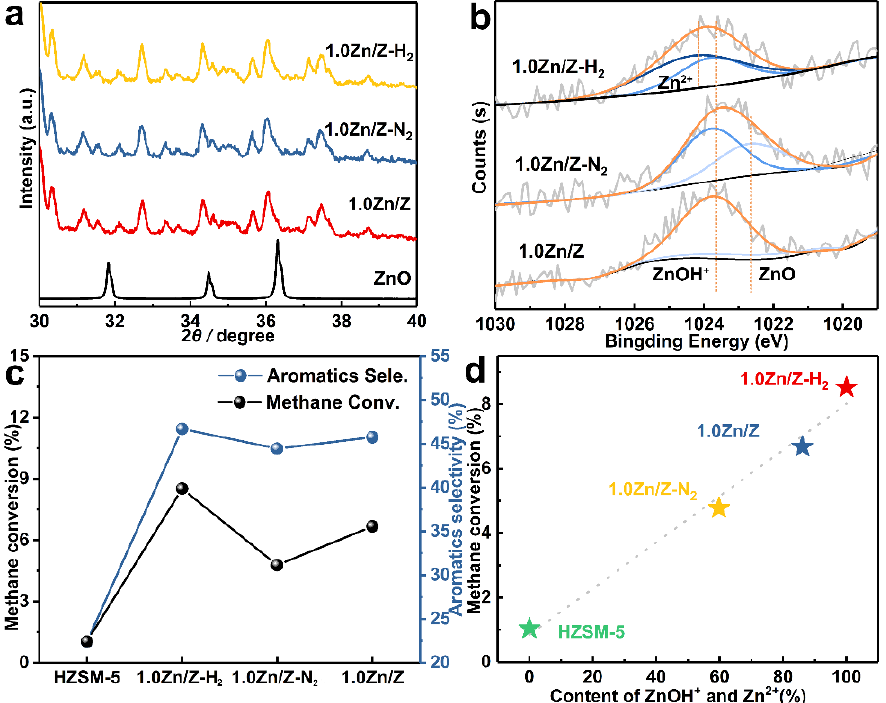
Table 4. Zn content of 1.0Zn/ZSM-5-25-IM catalyst calcined by different atmosphere.